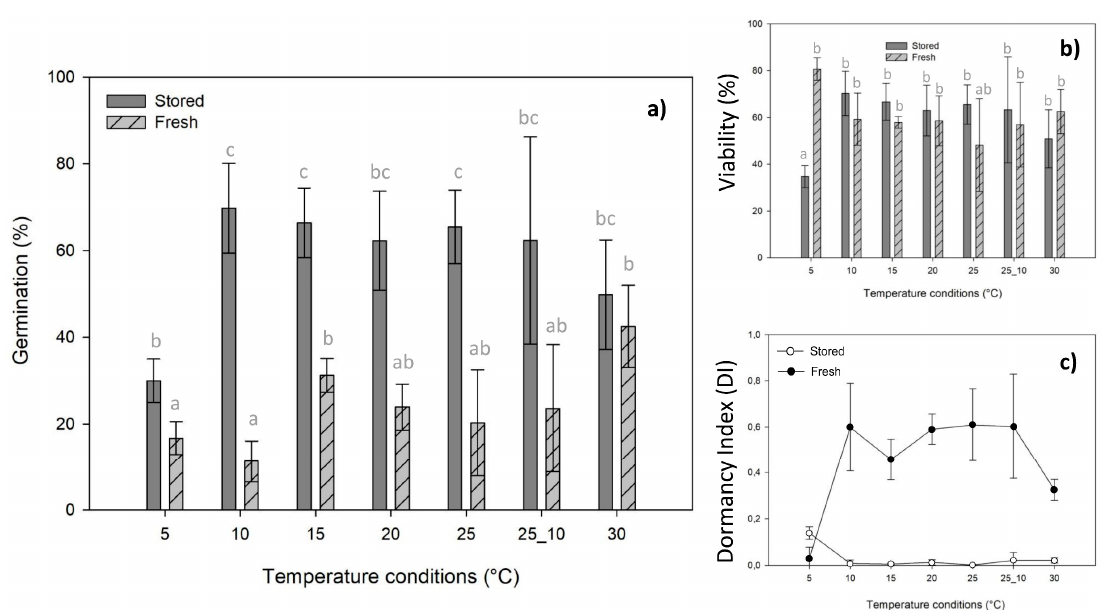
Figure 1. ( a ) Final germination percentages (FGPs) achieved at the end of the germination tests for each seed conditions (stored and fresh). ( b ) Percentage of seed viability at the end of the germination tests. Seed viability was calculated as sum of germinated seeds and filled seeds. Post hoc pairwise t -test comparisons were carried out for each germination temperature, and bars with di ff erent letters (a, b, c) indicate significant ( P < 0.05) di ff erences. ( c ) Dormancy index (DI) by temperatures of stored and fresh seeds at the end of germination